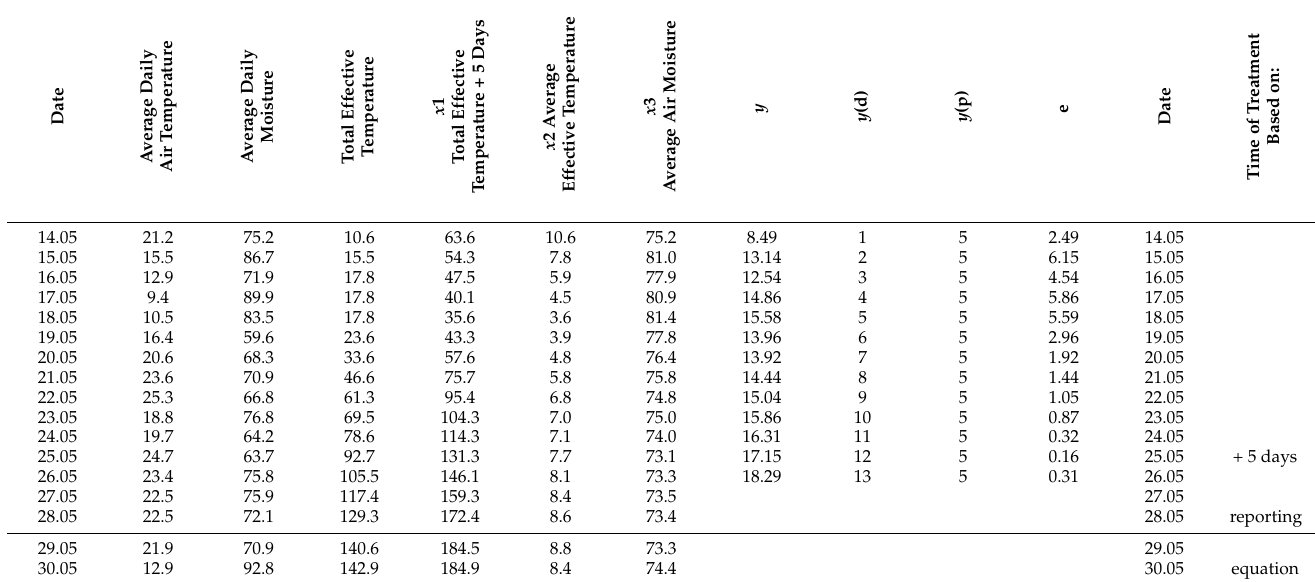
Table 5. Identifying best timing of cereal leaf beetle control measures in 2007 in Winna G ó ra with the use of the regression equation based on the duration of egg incubation periods for both species of Oulema